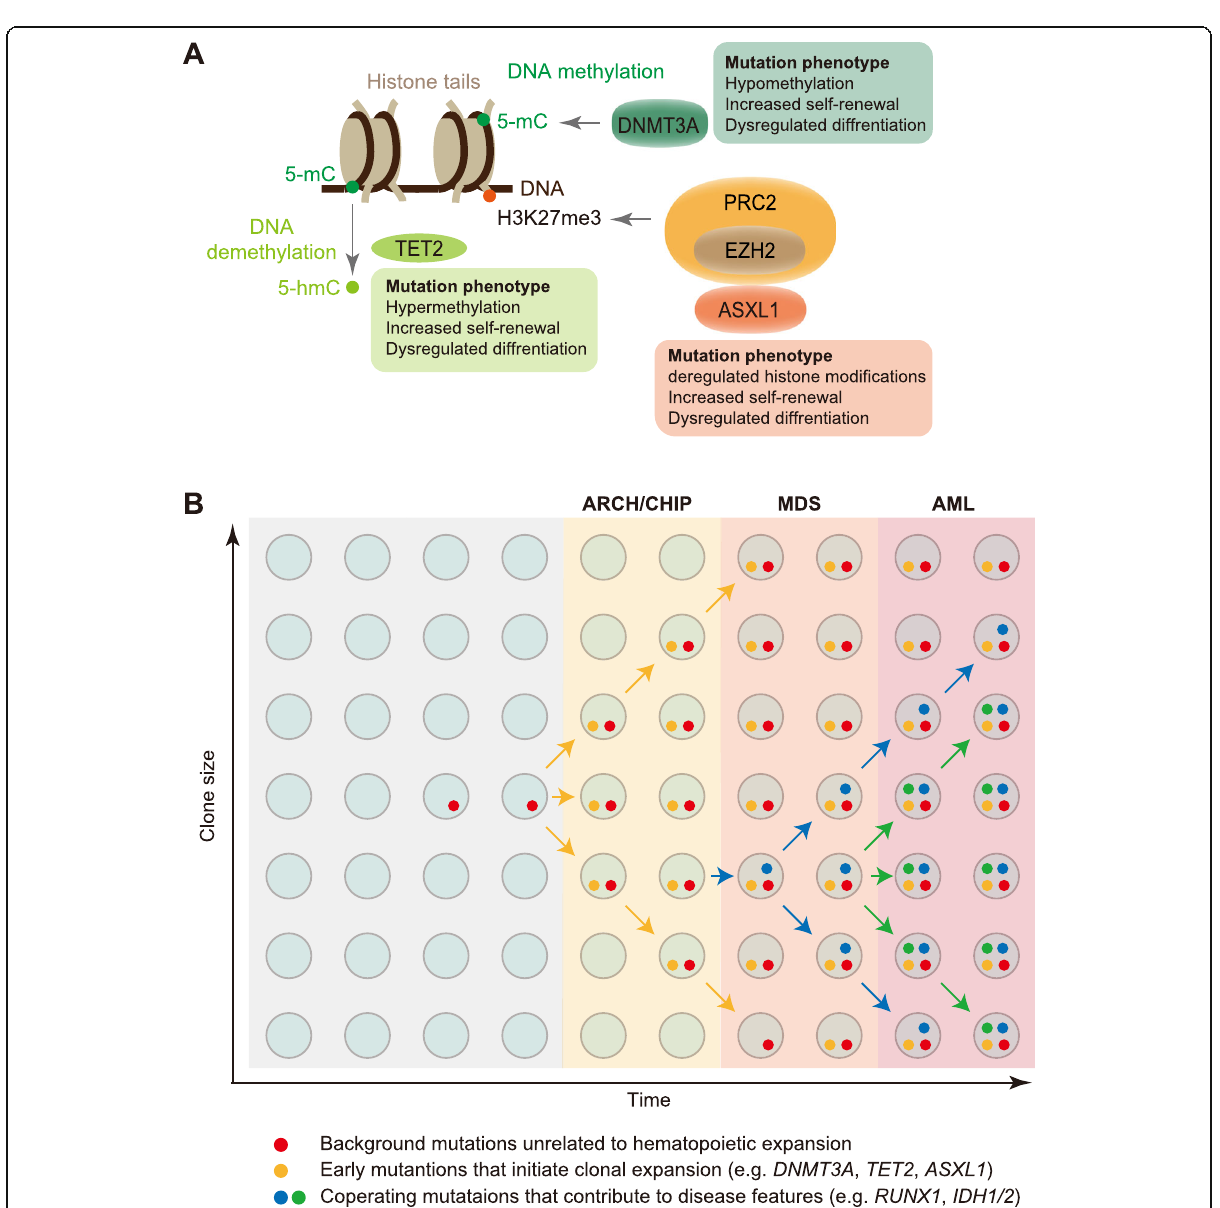
Fig. 2 Epigenetic regulators of clonal hematopoiesis. a Schematic representation of major epigenetic regulators involved in clonal hematopoiesis and age-associated myeloid malignancies. Mutation phenotypes of DNMT3A , TET2 , and ASXL1 are summarized. 5-mC, 5-methylcytosine; 5-hmC, 5- hydroxymethylcytosine; H3K27me3, trimethylated H3 at lysine 27. b Age-associated clonal hematopoiesis. Age-related clonal hematopoiesis (ARCH)/clonal hematopoiesis of indeterminate potential (CHIP) is asymptomatic clonal hematopoiesis characterized mainly by mutations in TET2 , DNMT3A , or ASXL1 . ARCH/CHIP may progress with additional mutations such as RUNX1 , EZH2 , and IDH1/2 to MDS and ultimately AML. ARCH/CHIP may also progress directly to AML without an intervening MDS stage or to other conditions such as myeloproliferative neoplasms or lymphoid neoplasms. AML, acute myeloid leukemia; MDS, myelodysplastic syndrome; PRC, polycomb repressive